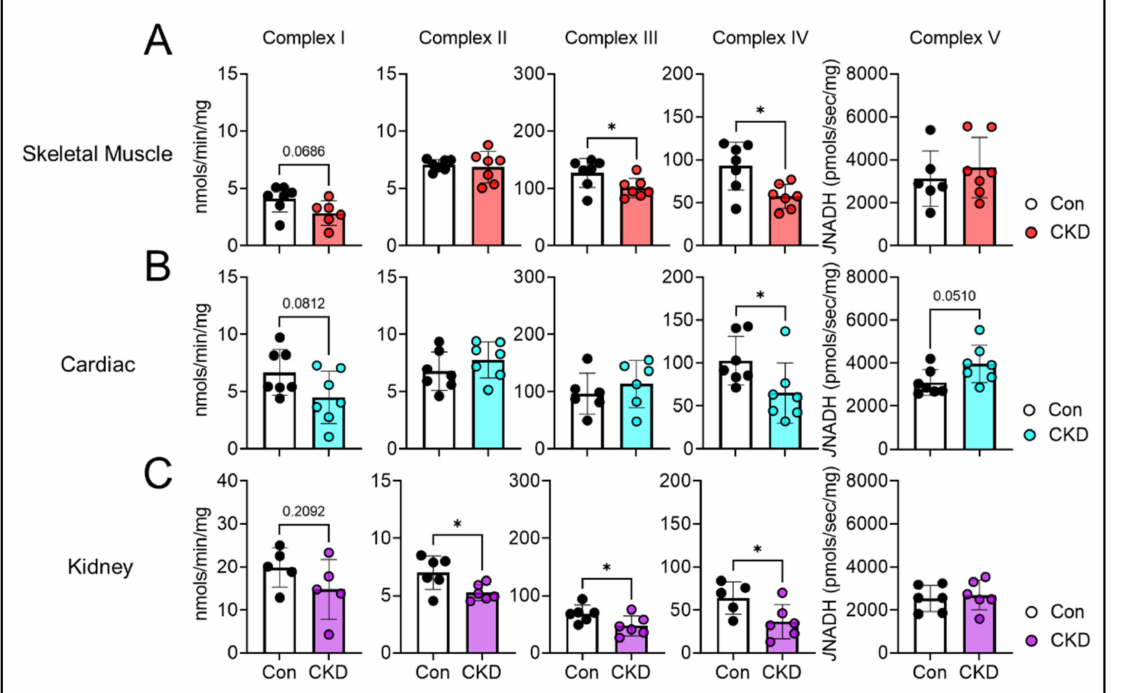
Figure 5. Activity of electron transport system enzyme complexes activity were measured using spectrophotometric bio- chemical assessments in ( A ) skeletal muscle mitochondria; ( B ) cardiac muscle; and ( C ) renal mitochondria ( n = 5–7/group). Data were analyzed using two-tailed unpaired t -test. Error bars show standard deviation. p < 0.05